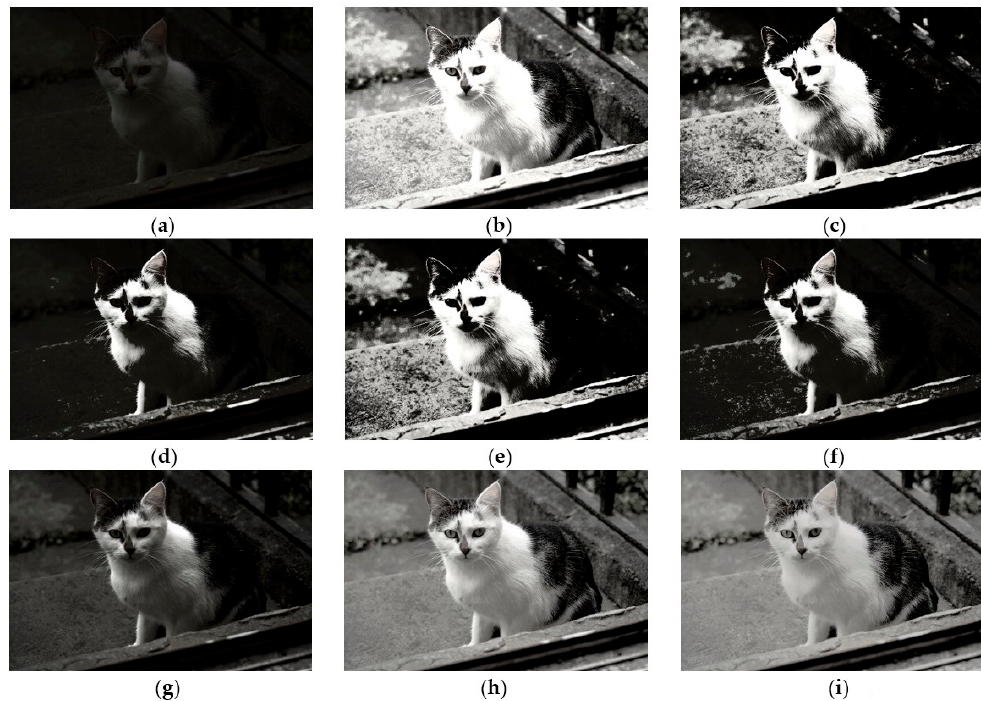
Figure 8. Results of different methods for the image Cat [26] (image size: 902 × 600 pixels): ( a ) Original image; ( b ) HE; ( c ) BBHE; ( d ) RMSHE (r = 2); ( e ) DSIHE; ( f ) RSIHE (r = 2); ( g ) DQHEPL; ( h ) VCEA; and ( i ) CegaHE.